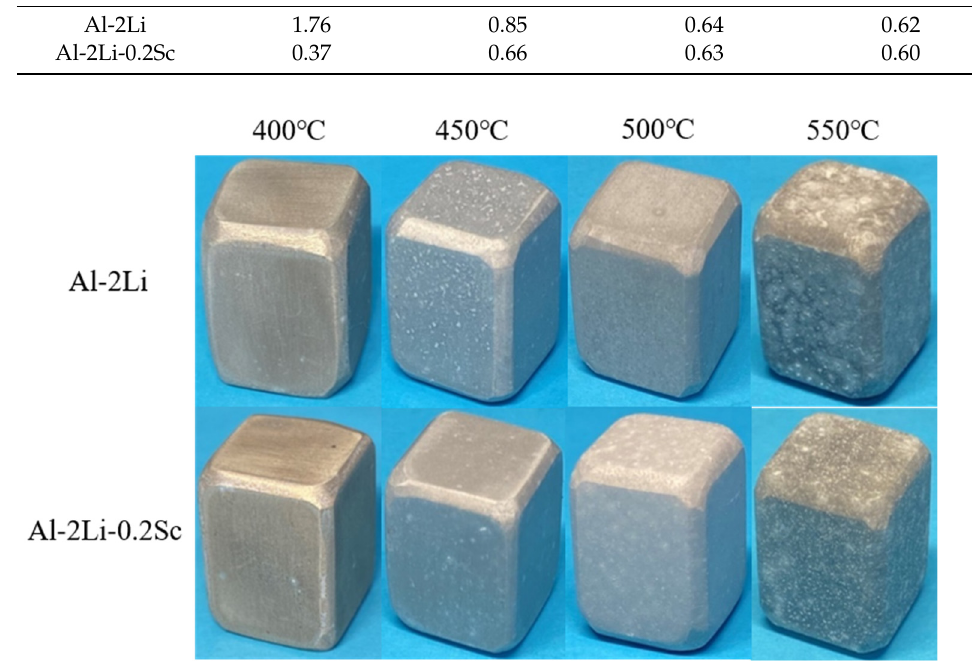
Figure 6. Macroscopic surface morphology of the alloy after oxidation.